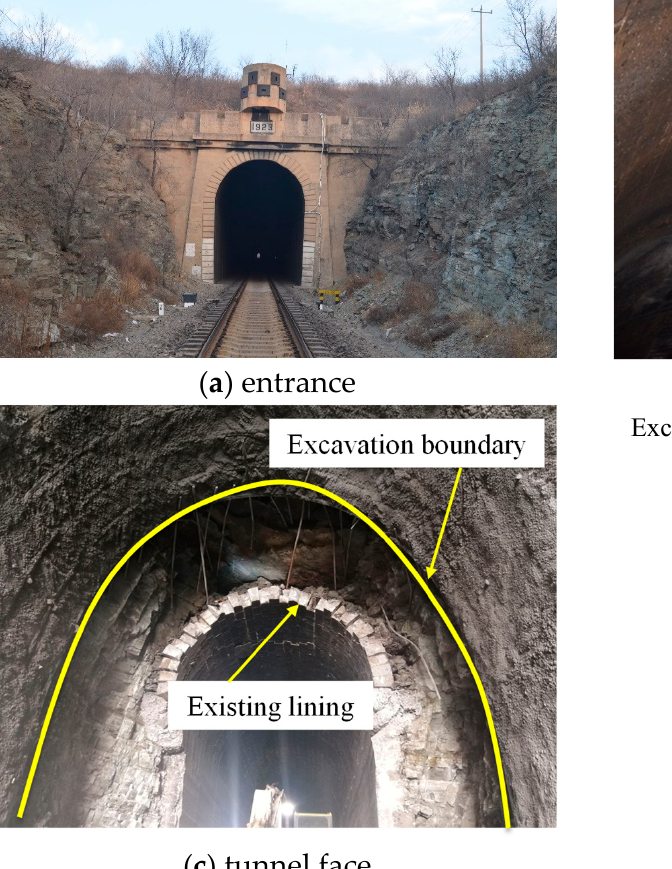
Figure 2. Nanling tunnel pictures.